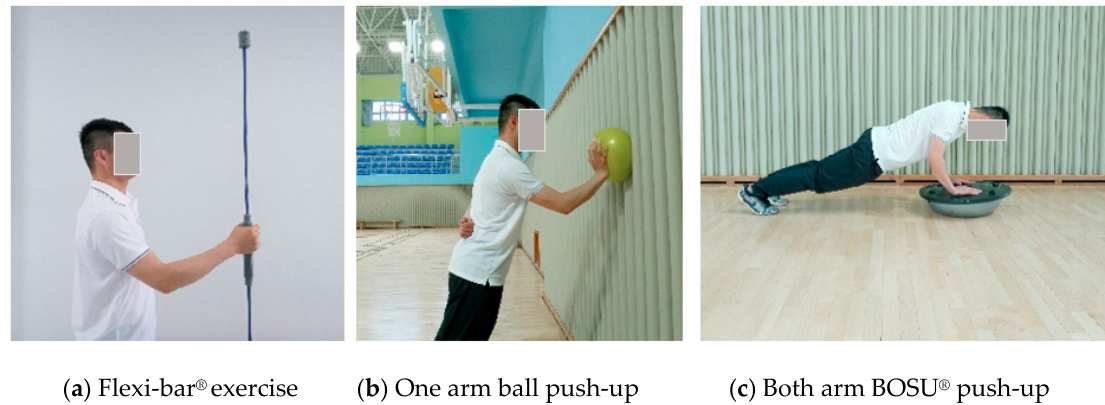
Figure 2. Neuromuscular training.